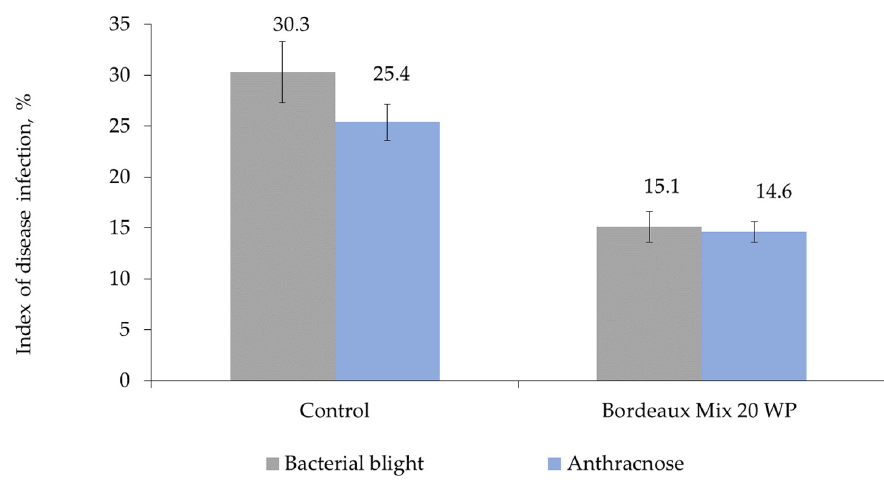
Figure 1. Development of bacterial blight and anthracnose in organic cultivation of snap bean. The relatively lower effect of the applied plant protection products during the growing season was likely because the used seeds were non ‐ treated before sowing. Hidden asymptomatic form of the infection resulted in a sustained increase in disease incidence in the crop over the years. The rate of seed infection increased over the years of the experimental period (Figure 2).